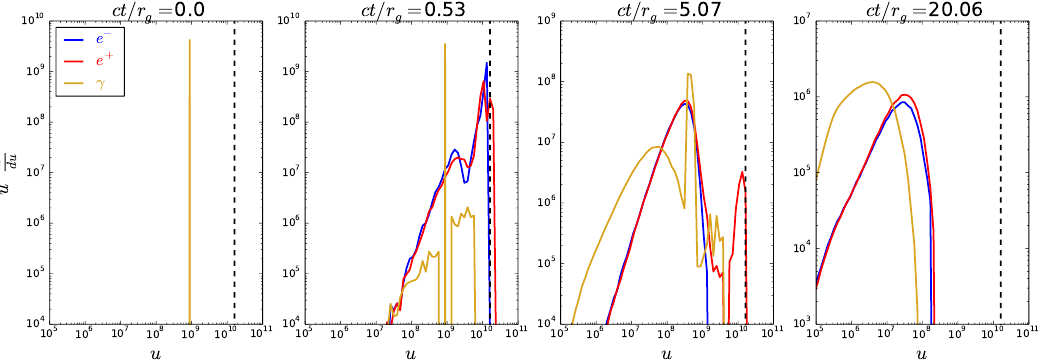
Figure 10. Evolution of the electron (blue), positron (red) and photon (yellow) spectra for the case shown in Figure 9. The photon energy is given in m e c 2 units. The peak of the quasi-steady gamma-ray spectrum in this example (rightmost panel) is at ∼ 1 TeV.